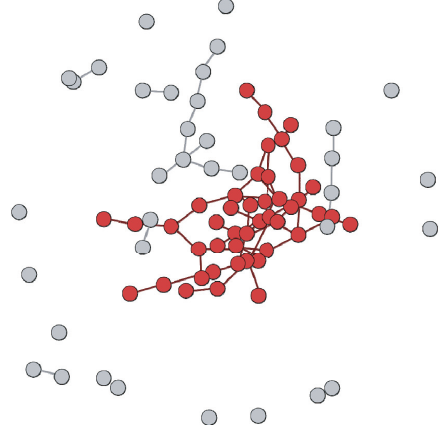
Figure 3: Intermediate state of alliance development.